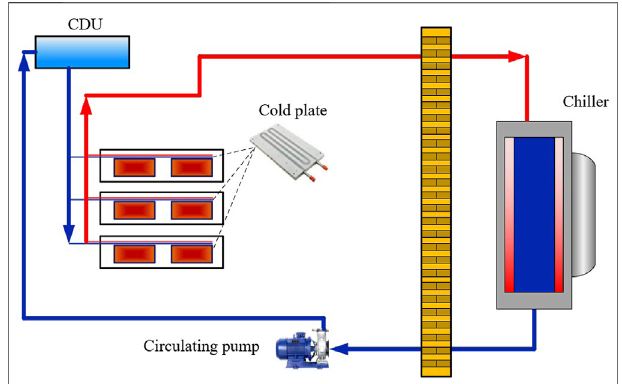
FIGURE 1 | Principle diagram of cooling plate-based liquid refrigeration technology in data centers.